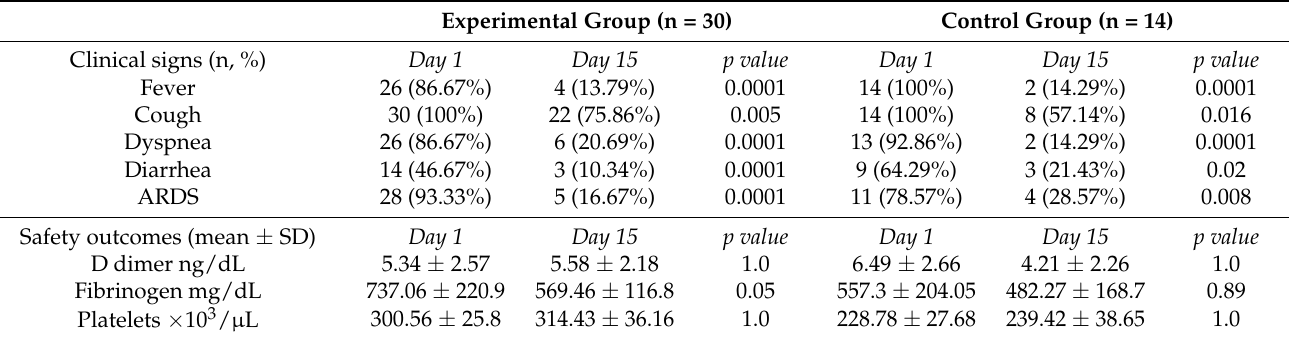
Table 2. Clinical signs patients and safety outcomes measured of